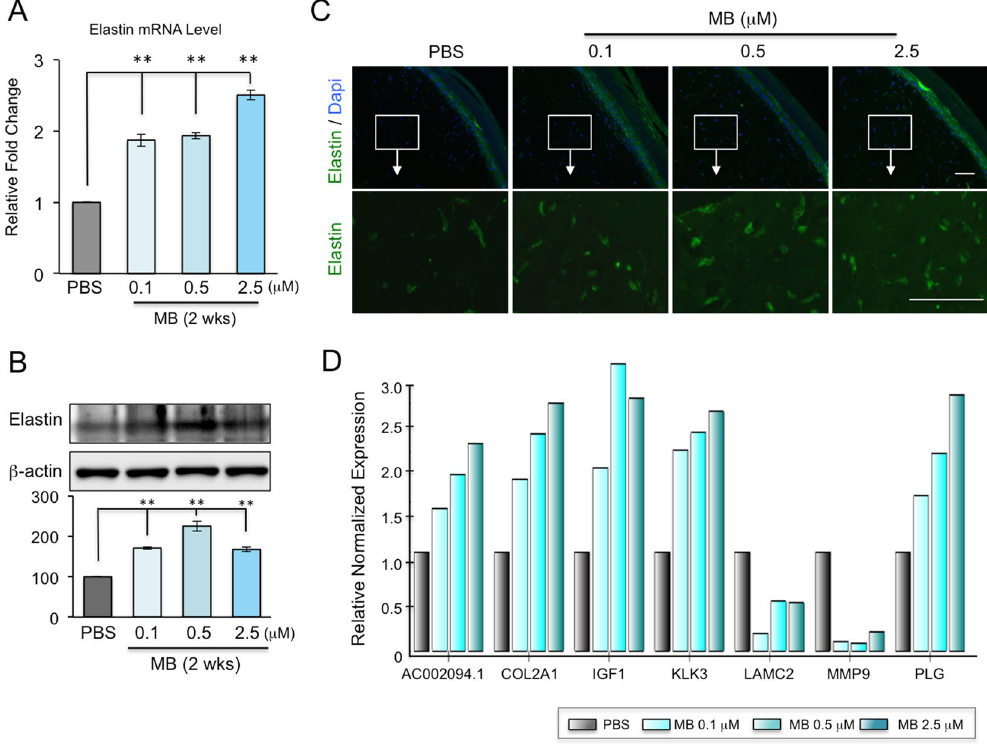
Figure 6. MB upregulates elastin expression and alters other ECM genes expression on 3D skin tissue. ( A ) Quantitative PCR analysis showing significantly upregulated mRNA levels of elastin in EFT-412 skin tissue after two weeks of MB treatment at 0.1, 0.5, or 2.5 μ M. ( ** p < 0.01) ( B ) Western blotting analysis showing increased elastin protein amounts in EFT-412 skin tissues upon two-week treatment of MB at 0.1, 0.5, or 2.5 μ M. ( ** p < 0.01) ( C ) Representative IHC images showing the signals from an anti-elastin antibody (green) on the paraffin slides of 3D skin tissues. Two-week treatment with MB raised elastin signals compared to PBS treatment. Scale bar = 100 μ m. ( D ) qPCR analysis showing the significantly up- or down-regulated ECM genes in EFT-412 skin tissues in response to MB treatment compared to PBS